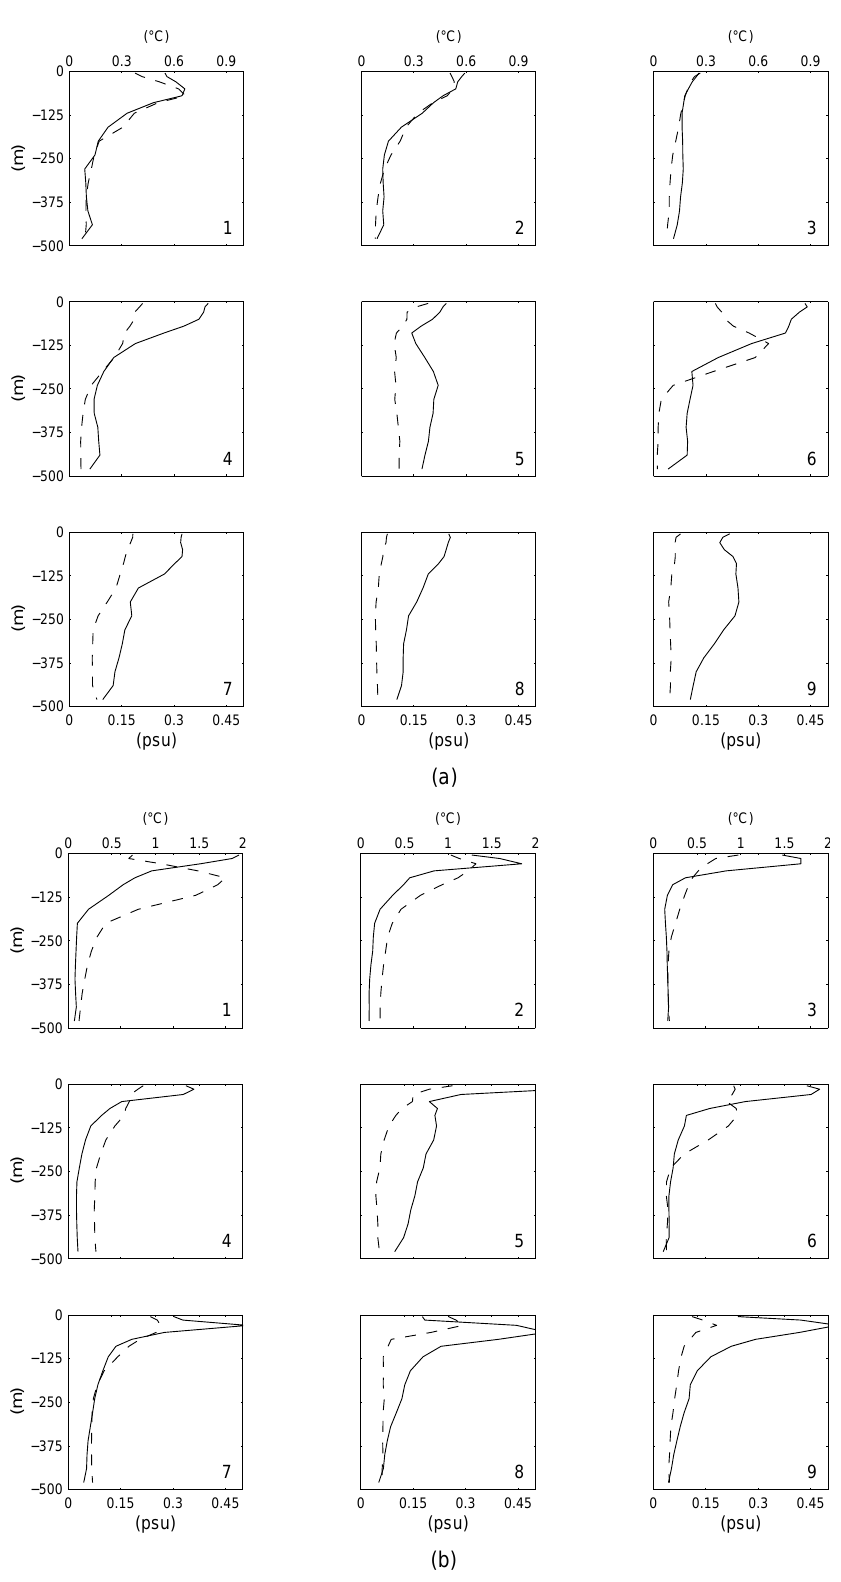
Fig. 4. Vertical profiles of the standard deviations from climatology for temperature (solid curve) and salinity (dotted curve). The insitu data for the nine regions (indicated in the lower right corner) are shown for winter (a) and summer (b) . Model simulation results are shown in (c) for winter and (d) for summer (Fig. 4